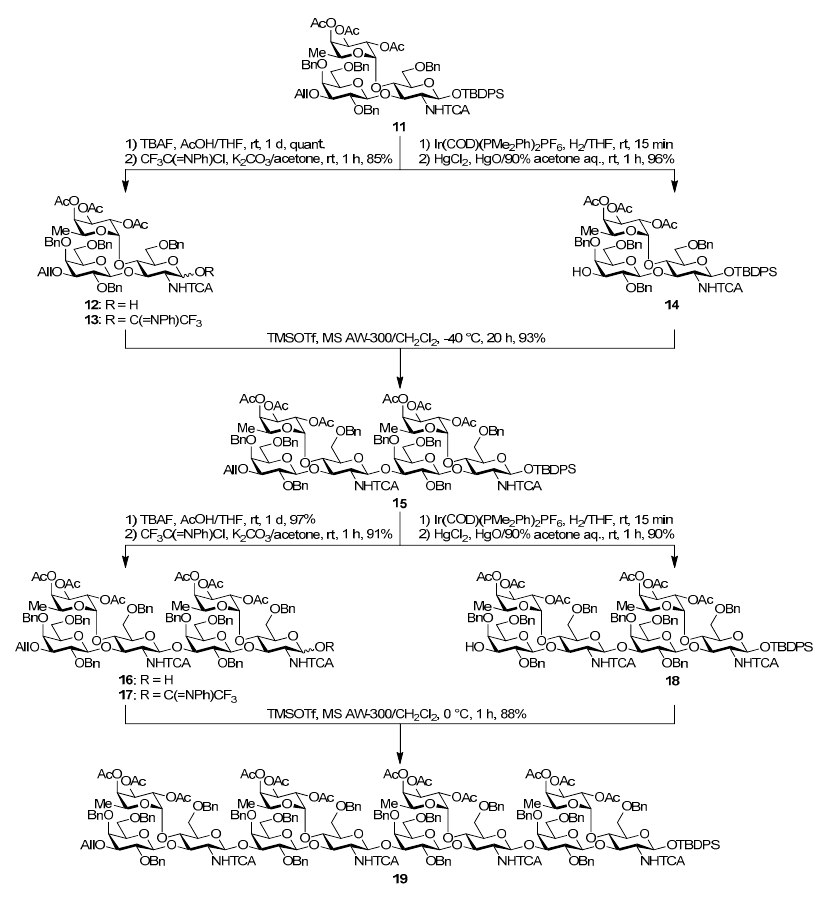
Scheme 3. Synthesis of Le a tetramer.